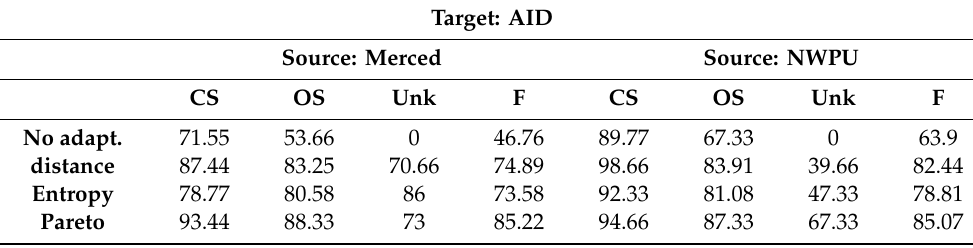
Table 2. Classification results obtained for the scenarios: Merced → AID and NWPU → AID for an openness = 25%.